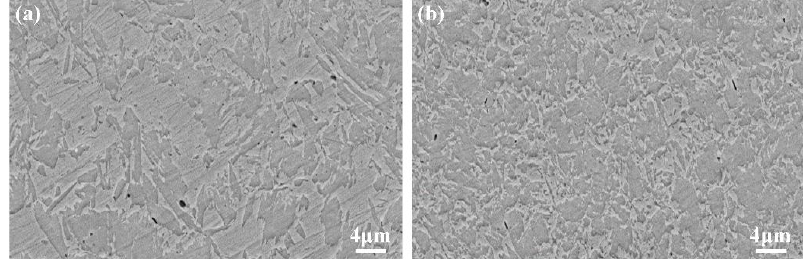
Figure 4. SEM micrographs of SZ: ( a ) SZ-top and ( b ) SZ-bottom.